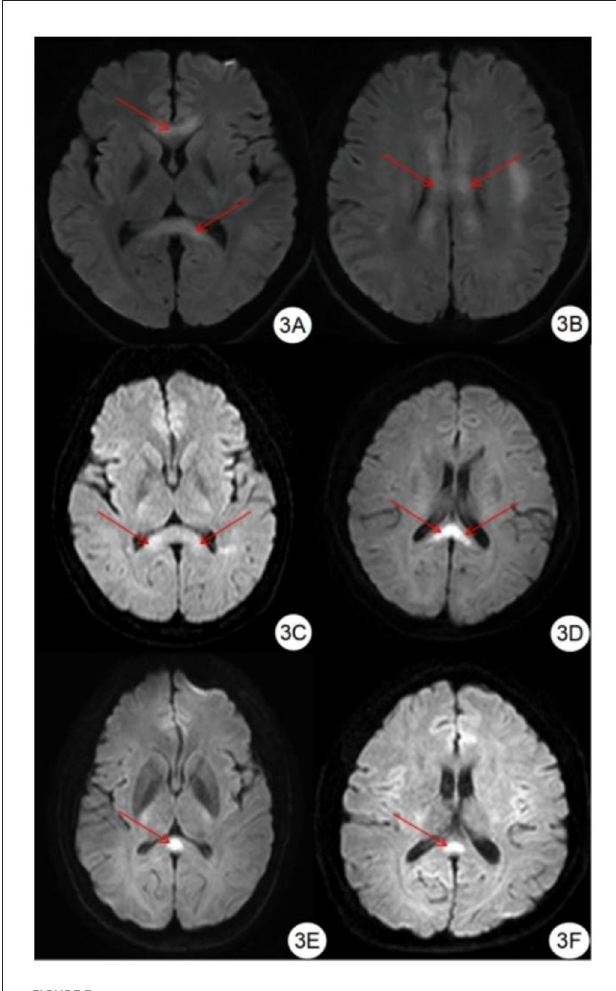
FIGURE3 Classification of edema in corpus callosum region. (A, B) DWI showed symmetrical hyperintensity in the splenium, trunk, and genu of the corpus callosum. (C, D) DWI showed symmetrical hyperintensity in the splenium of the corpus callosum. (E, F) DWI showed hyperintensity in the center of the splenium of the corpus callosum.